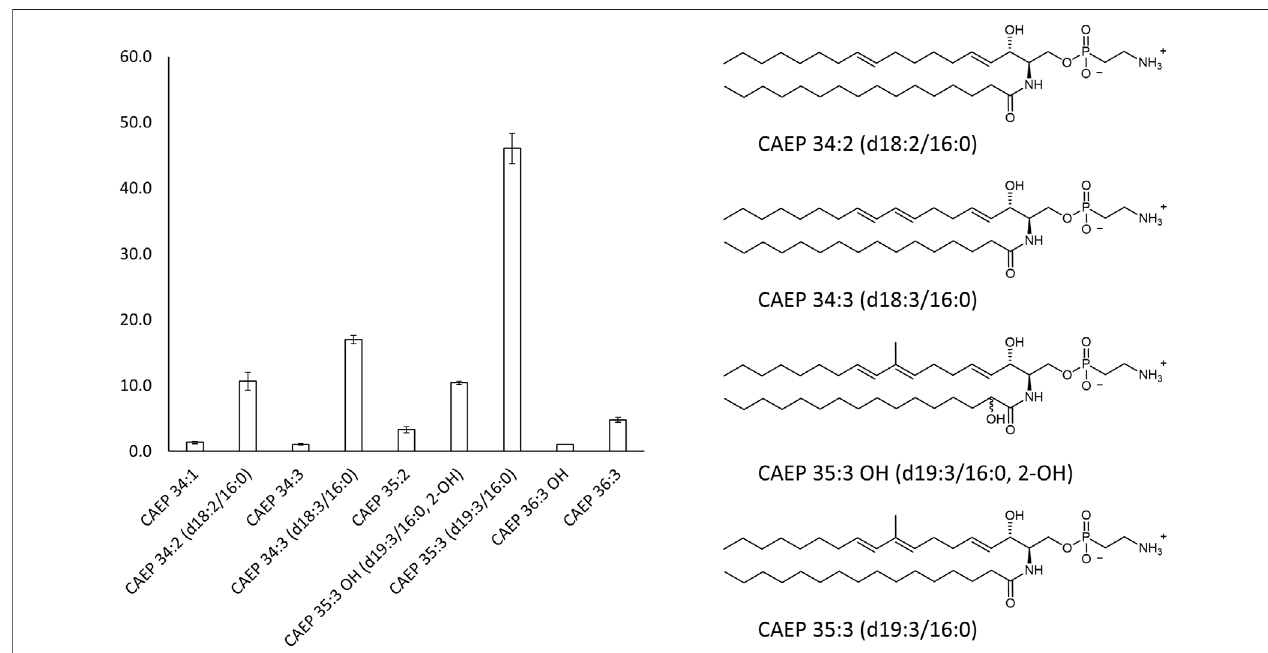
FIGURE 3 | Main CAEP relative components of the M. galloprovincialis hemocytes raw extract ( > 3 mol%) and their corresponding structures.